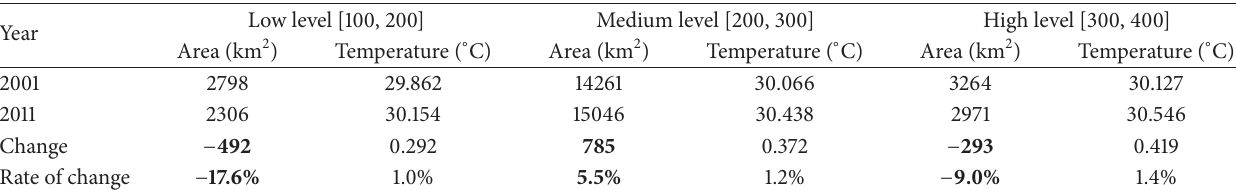
Figure 4: The average LSTs and changes in 2001 and 2011 (all figures depict summer: July, August, and September). Table 4: Dynamic changes in the land-use intensity and temperature between 2001 and